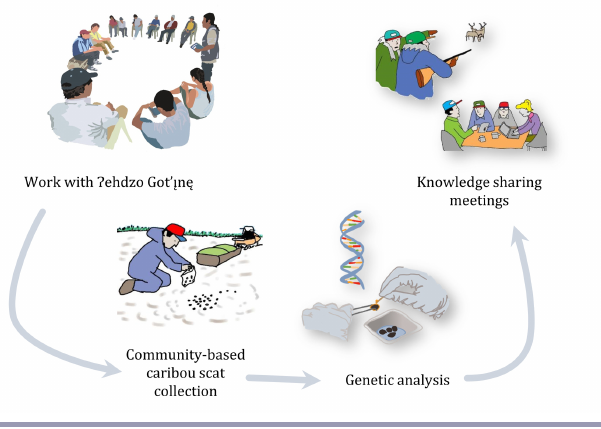
Fig. 2 . Diagram depicting the